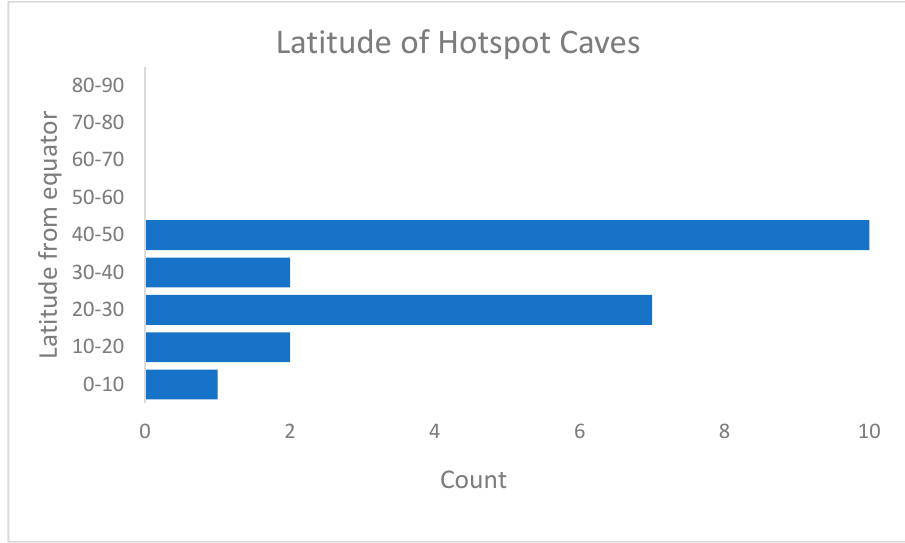
Figure 2. Distribution distances from the equator of the subterranean hotspot sites listed in Table1.